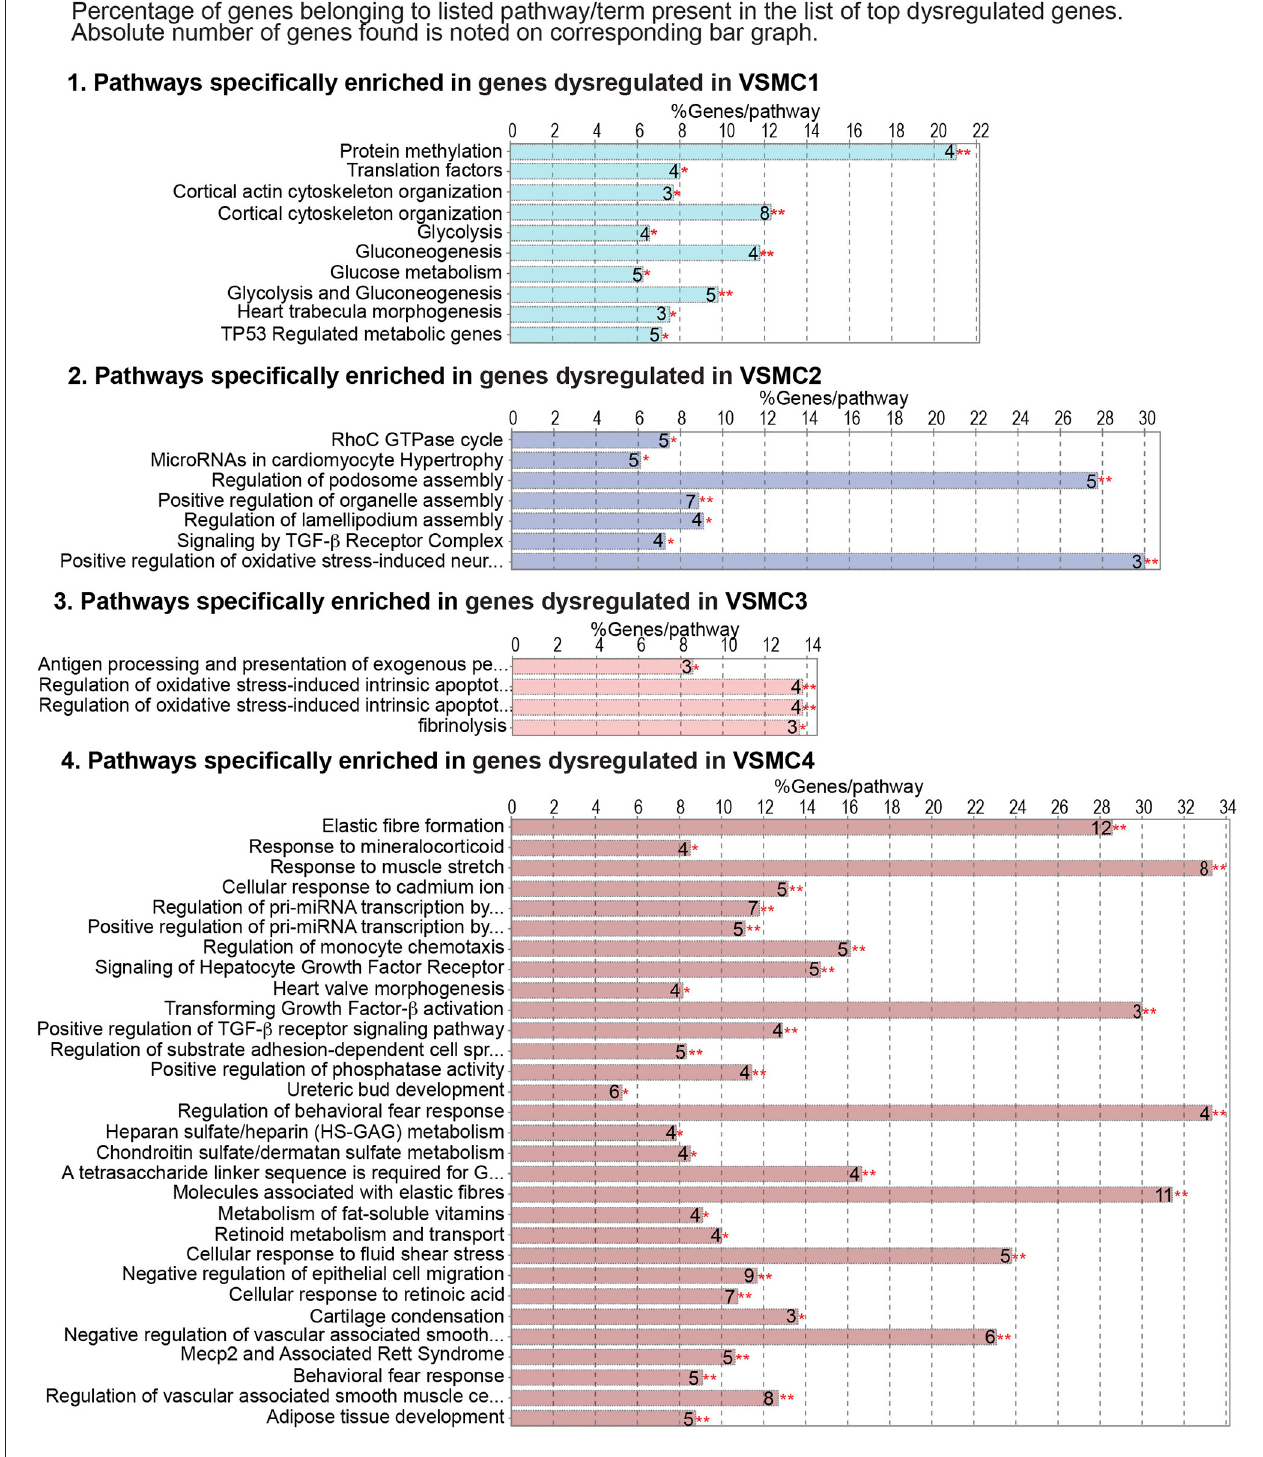
FIGURE 7 | Genes dysregulated in individual VSMC subsets show enrichment for specific pathways. Cluster-specific gene enrichment results as calculated by ClueGO for the top 200 dysregulated transcripts for each VSMC subset. Bar graphs shows the percent of genes belonging to a given term, while the absolute number of genes for each term is indicated as a number next to the corresponding bar. Asterisks refer to the significance of enrichment as calculated by ClueGO algorithm and corrected using the Benjamini-Hochberg method for multiple testing correction.